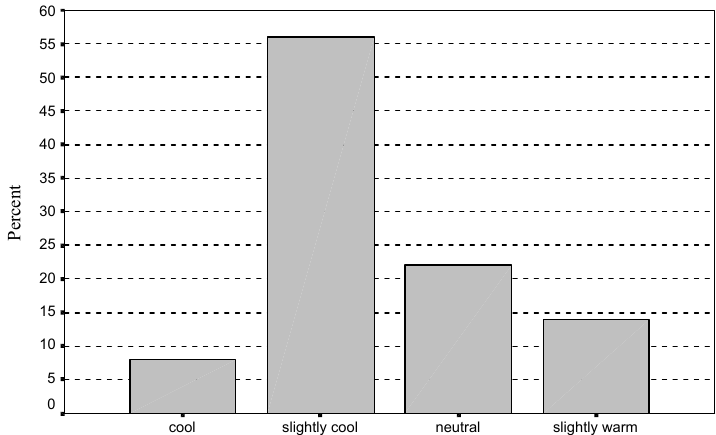
Figure 6. Southern Europe atrium sensation votes in the cool